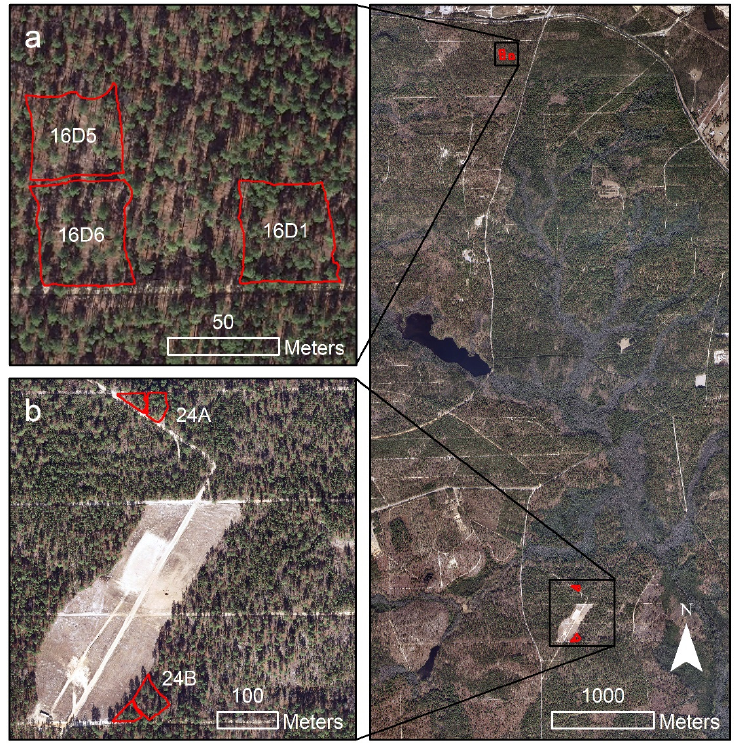
Figure 2. Location of individual burn plots at Ft. Jackson showing experimental burn units in man- agement areas ( a ) 16D and ( b ) 24A and 24B. management areas ( a ) 16D and ( b ) 24A and